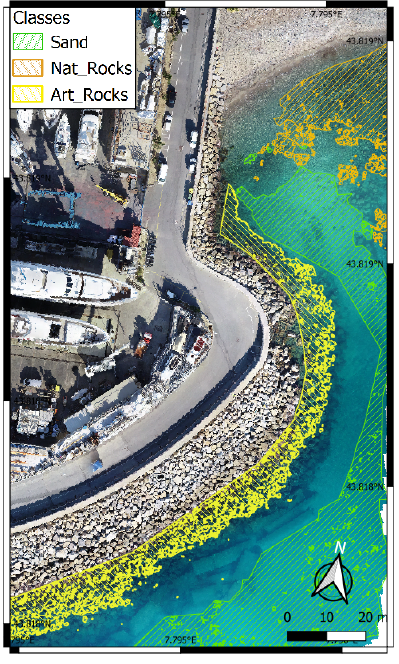
Figure 13. Seabed classification: areas with the same classes of seabed identified by the three classifiers, i.e., sandy areas (green), natural rocks (orange) and artificial rocks (yellow). The UAV- derived orthophoto is used as background. Portosole (beach area excerpt).